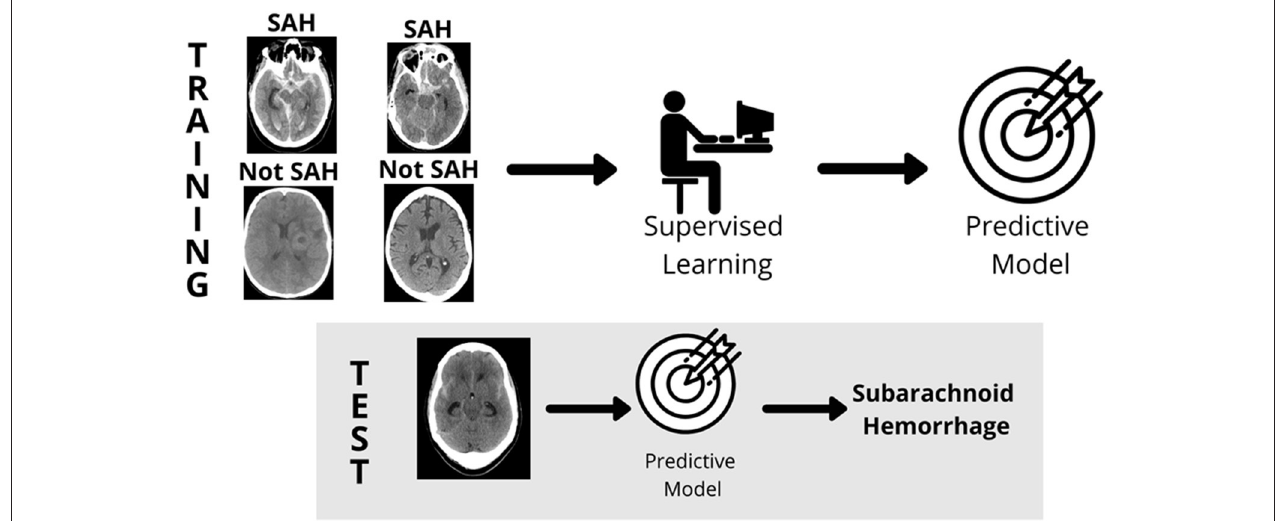
FIGURE 1 | Supervised learning. In supervised learning, a model is built by labeling images [Subarachnoid Hemorrhage (SAH) and Not Subarachnoid Hemorrhage (Not SAH)], a predictive model is created, and then tested for accuracy in reading unlabeled images (gray box). Source: WesternDigital BLOG.